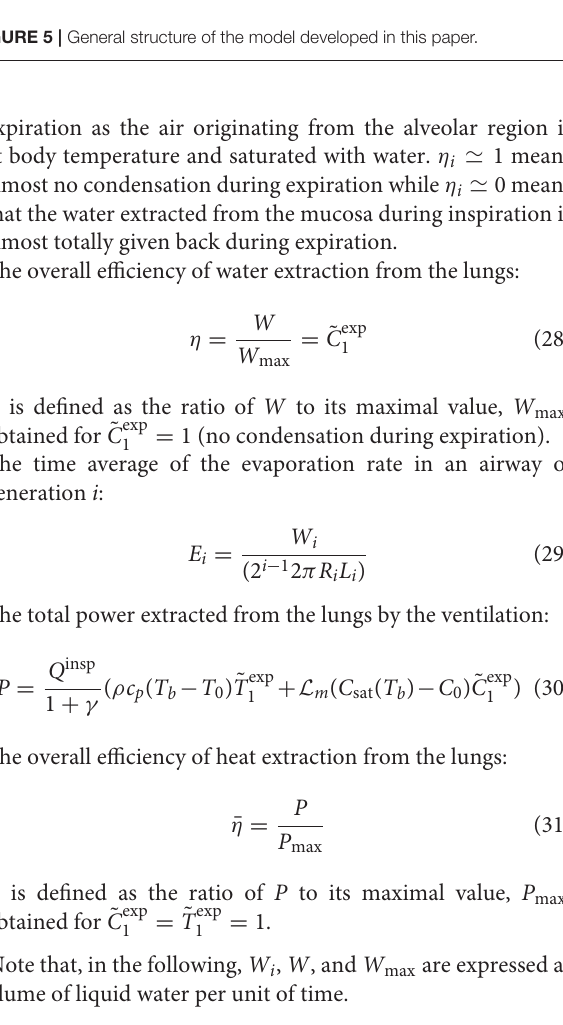
FIGURE 5 | General structure of the model developed in this paper.